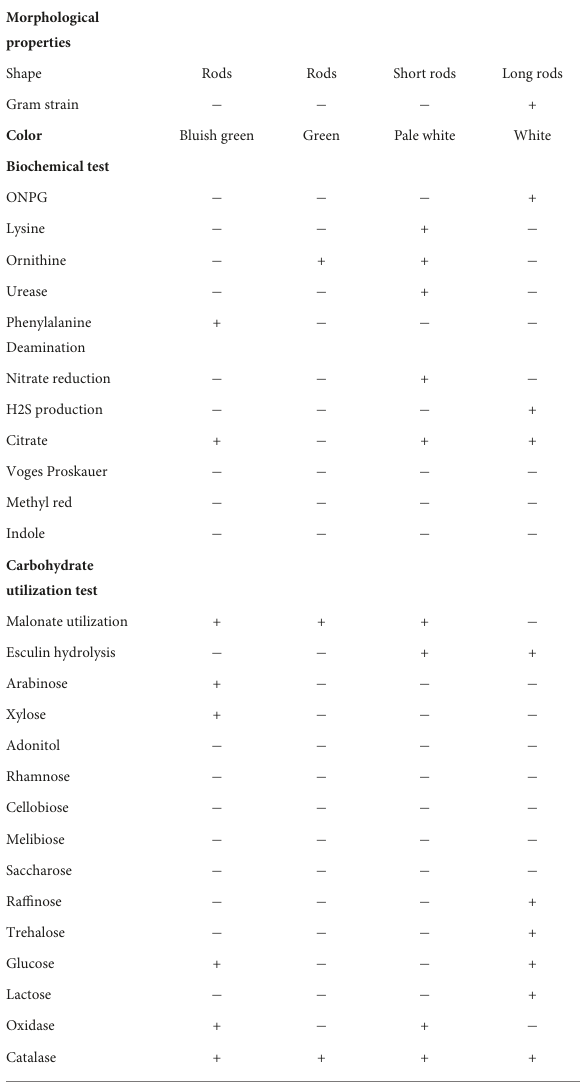
TABLE 3 Morphological and biochemical properties of the screened PCB degrader’s. Screened